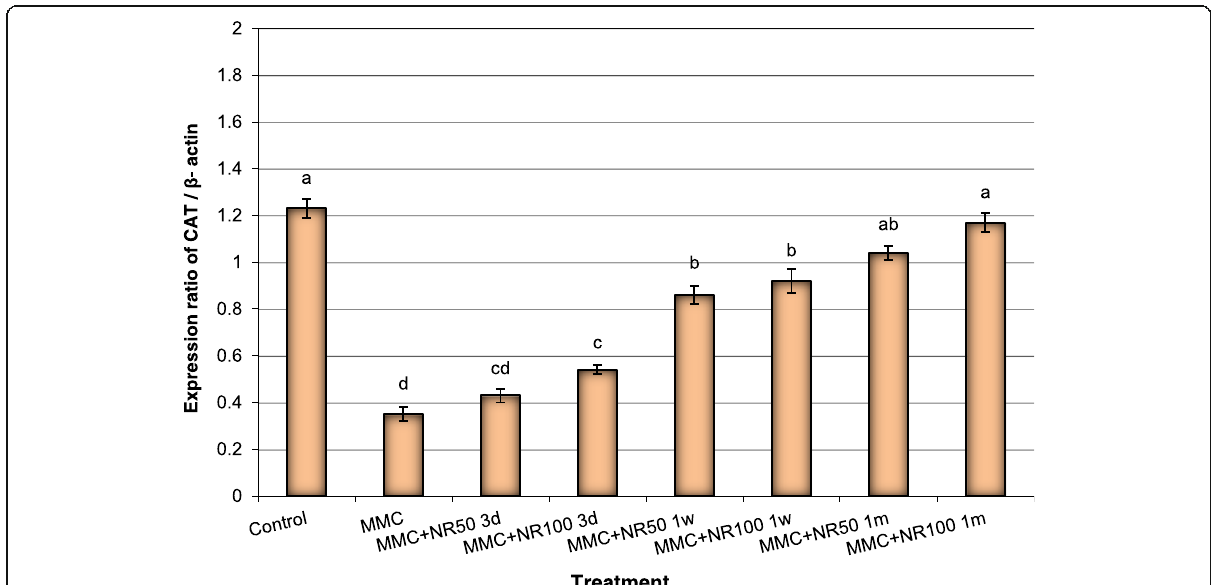
Fig. 1 Expression alteration of CAT gene in liver tissues collected from MMC-treated mice supplemented with different doses (50 and 100 mg/kg body wt) of Nitraria retusa leaf extracts at different time intervals (3 days, 1 week, and 1 month). Data are presented as mean ± SEM. a,b,c,d Mean values within tissue with unlike superscript letters were significantly different ( a P < 0.01, b,c,d P < 0.05)